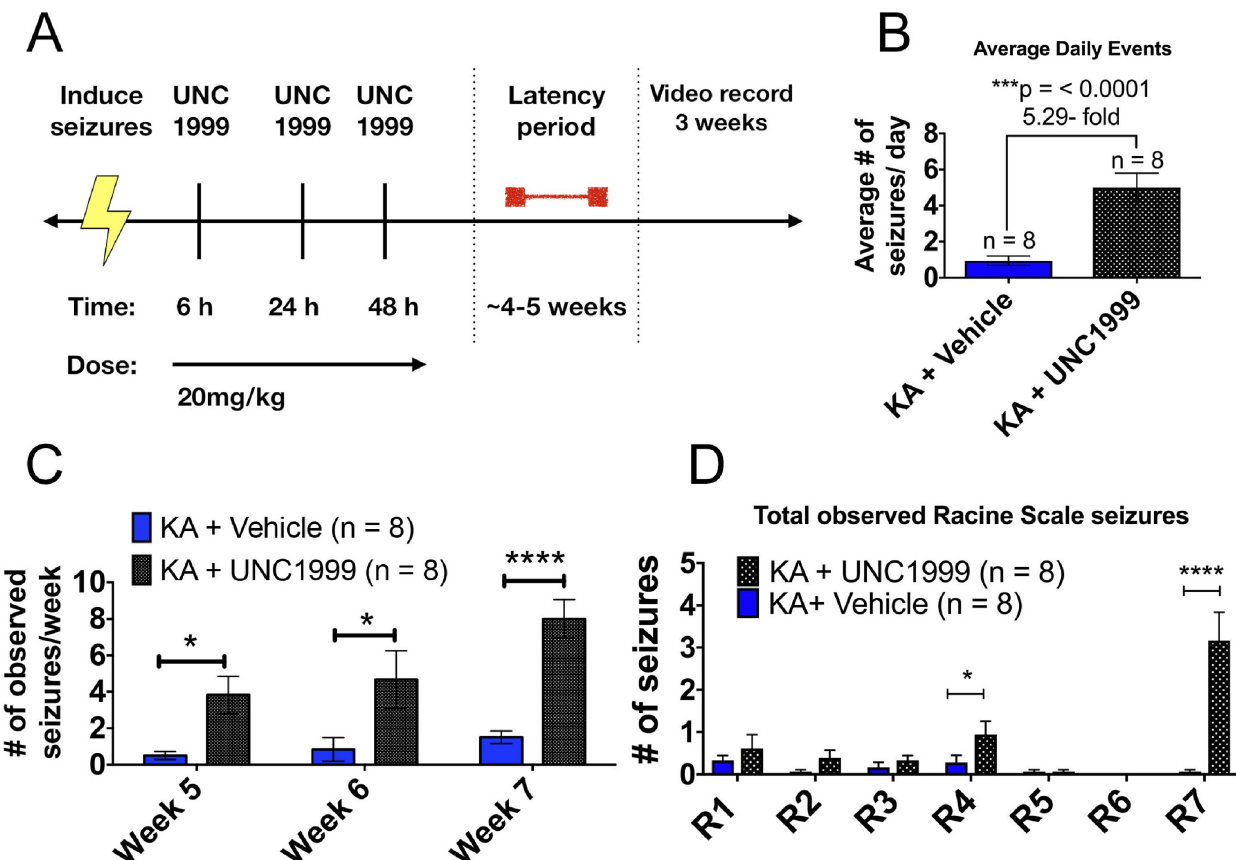
Fig 6. Inhibition of EZH2 in vivo increases seizure burden in KA treated mice. (A) Schematic of UNC1999 dosing regimen used with KA to test animals. Briefly, animals were induced to SE and then dosed three times with 20mg/kg UNC1999 at 6, 24 and 48 hours. Animals were allowed to recover for 4–5 weeks and then scored through video monitoring for 3 weeks. Two observers blinded to treatment groups scored all videos. (B) KA + UNC1999 exhibited 5.29-fold more average seizures per day compared to vehicle treated animals (Student’s unpaired t-test with equal SD, p < 0.05). (C) KA+ UNC1999 treated animals demonstrate significantly greater number of seizure events per week of recording compared to vehicle treated mice (Two-way ANOVA test, p < 0.05, with Holm- Sidak correction). (D) KA + UNC1999 treated mice exhibited significantly more rearing and running, jumping and spinning in circles behavior compared to vehicle, suggesting a more severe disease progression. Statistical significance assessed by Student’s unpaired t-test with equal SD (p < 0.05), n = 6 saline + vehicle, n = 3 KA + vehicle and n = 7 KA + UNC1999 animals. � p < 0.05, �� p < 0.01, ��� p < 0.001, ���� p <